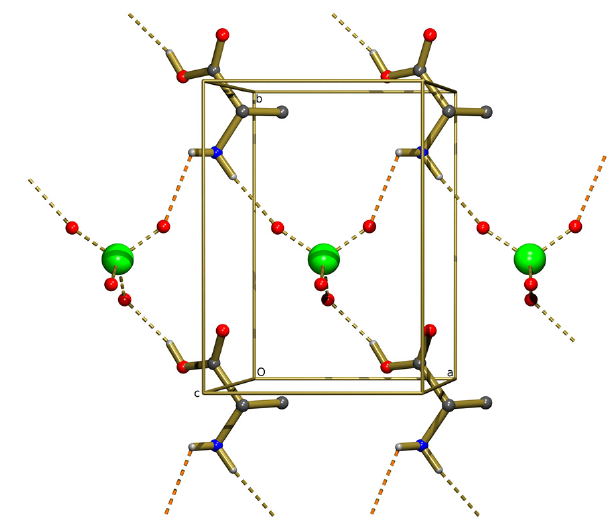
Figure 5. Hydrogen bonding between (100) planes. The last H-bond of table 4 (N1-H1A…O4) is shown in a different color. Table 4. Hydrogen bonds for LAlaRe (pm and